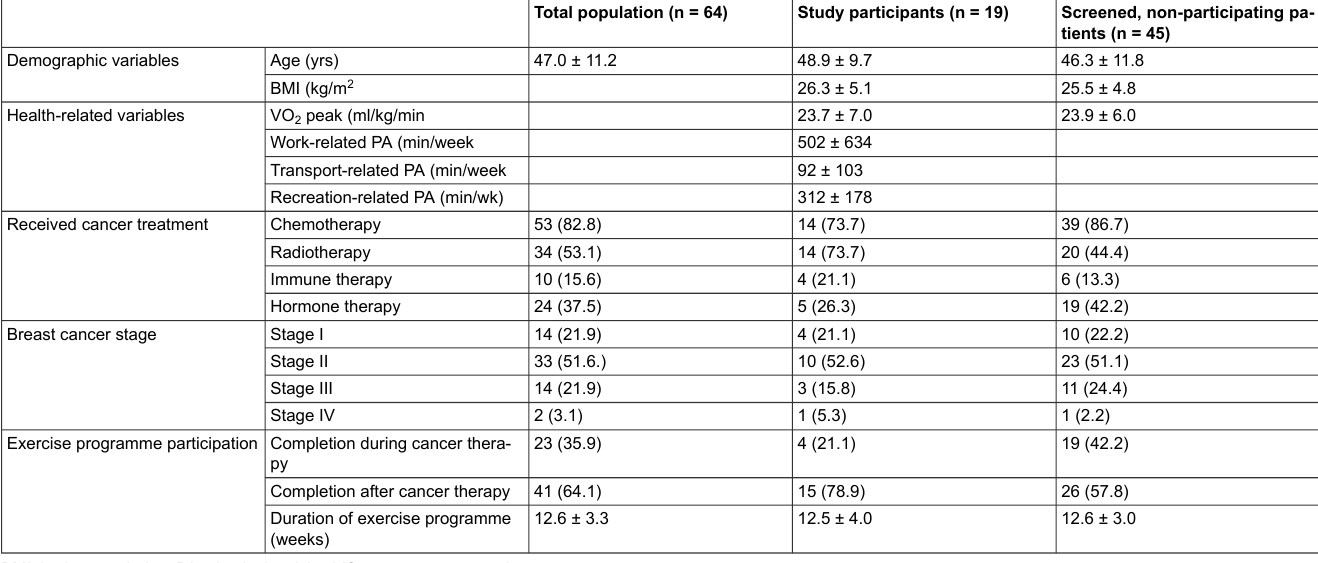
Table 1: Characteristics of the study